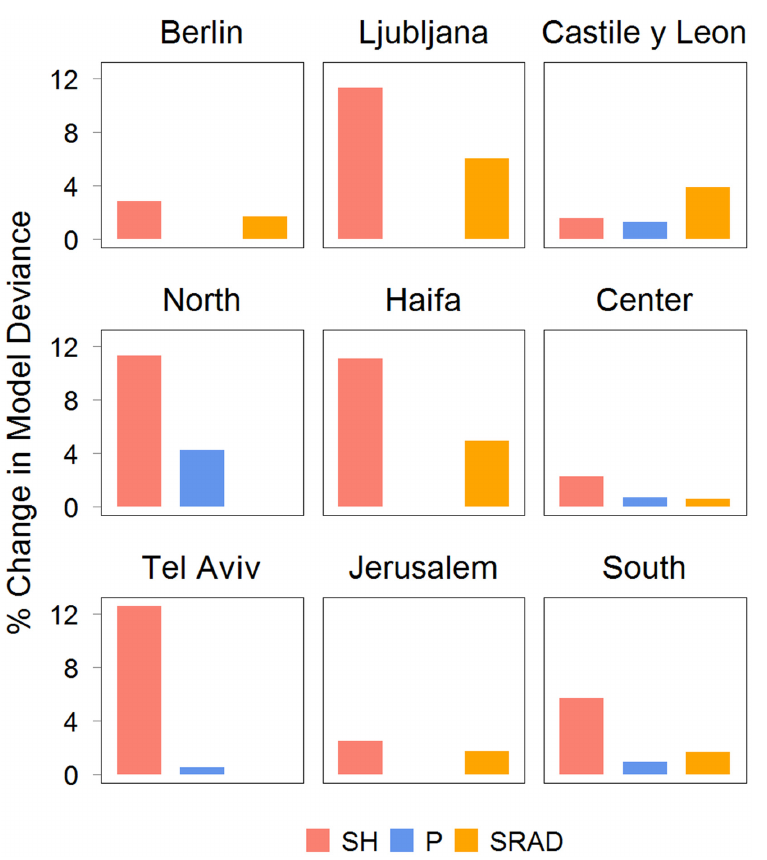
Fig 3. Percentage change in model deviance when the specified meteorological parameter was excluded from Model 2. SH is specific humidity, PRCP is precipitation and SR is solar radiation.